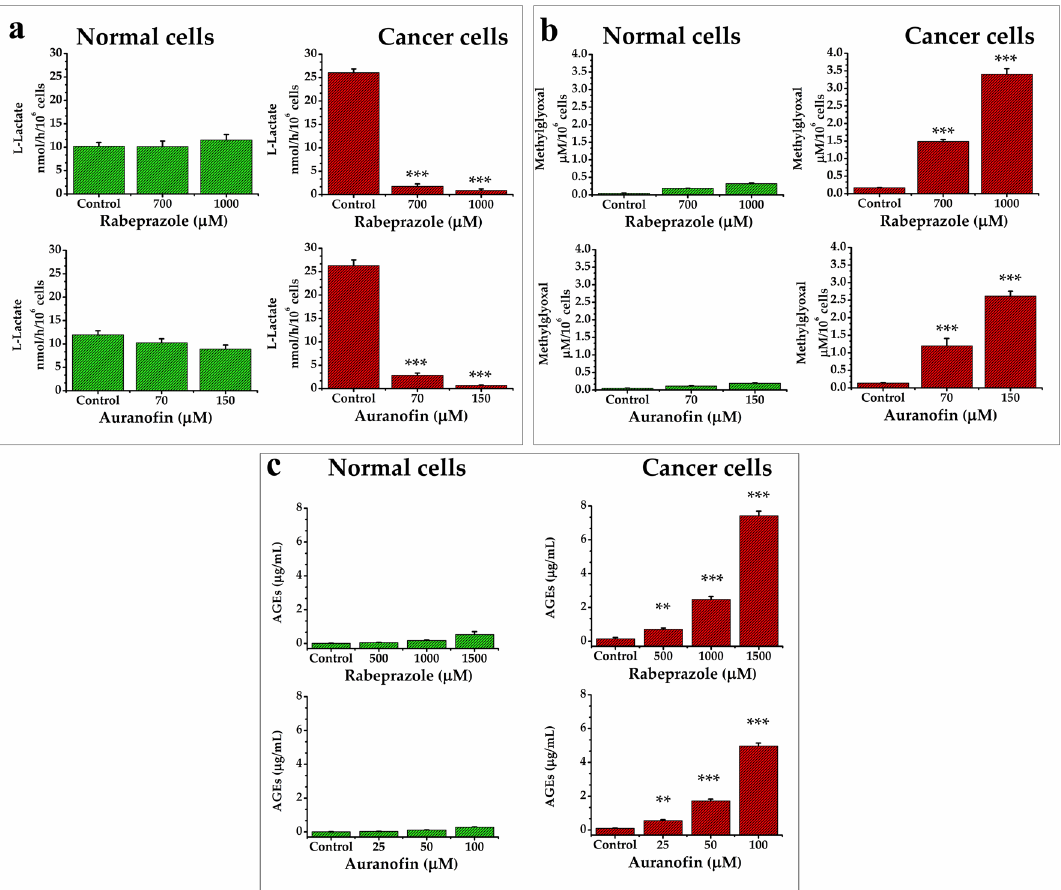
Figure 3. Quantification of metabolites in normal and cancer cells under drug treatments. Levels of lactate ( a ), methylglyoxal ( b ), and Advanced Glycation End products (AGEs) ( c ) in normal (green) and cancer cells (red) under rabeprazole (upper) or auranofin (bottom) treatments. Results represent the mean of at least four independent experiments. Differences among groups were assessed with one-way ANOVA and Tukey’s test with p value = 0.001 *** or with p value =